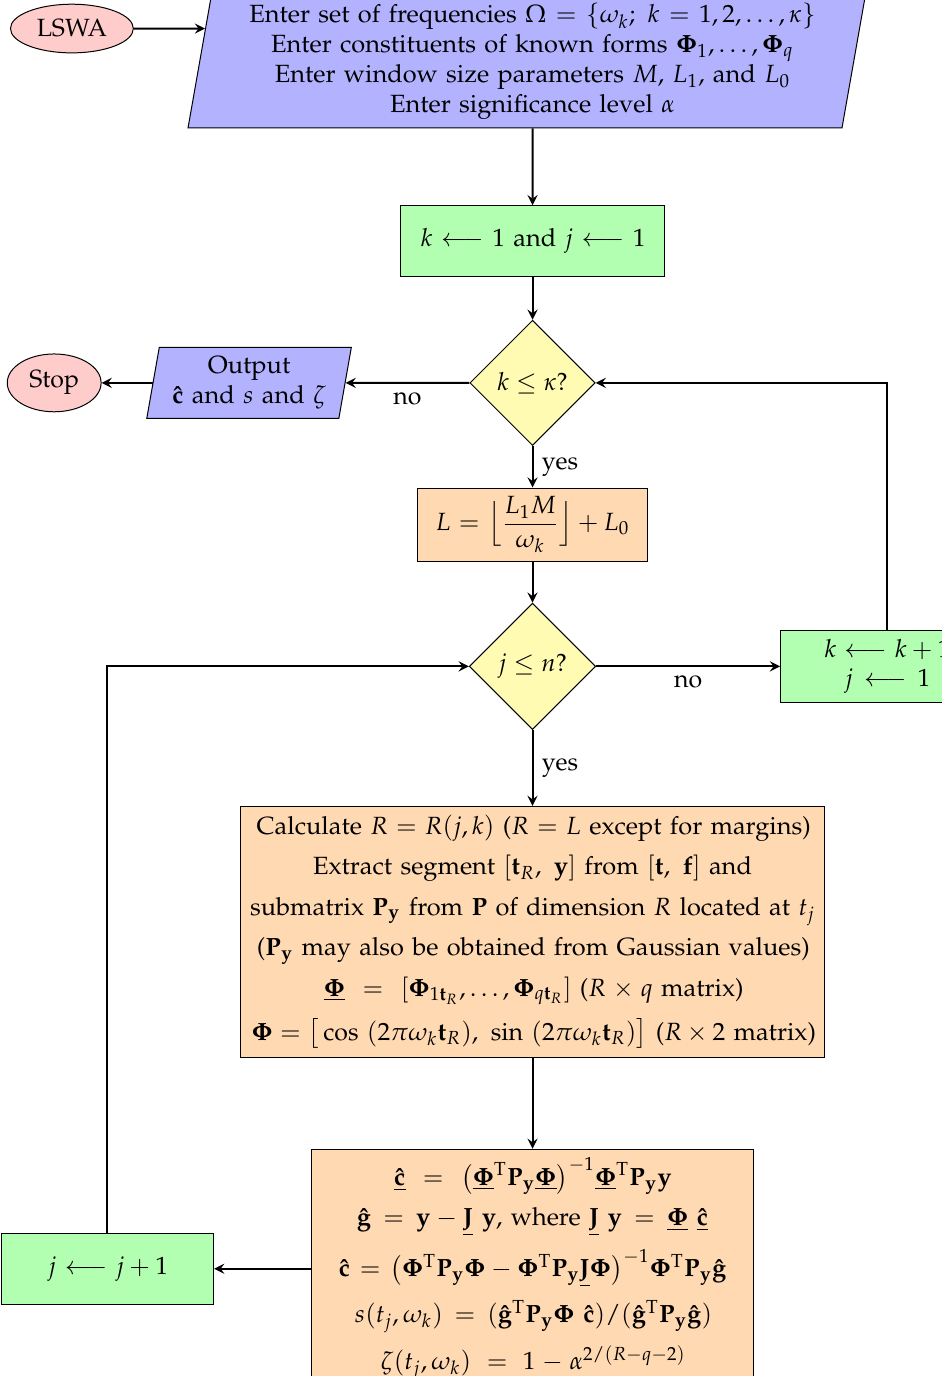
Figure A5. A flowchart of the LSWA